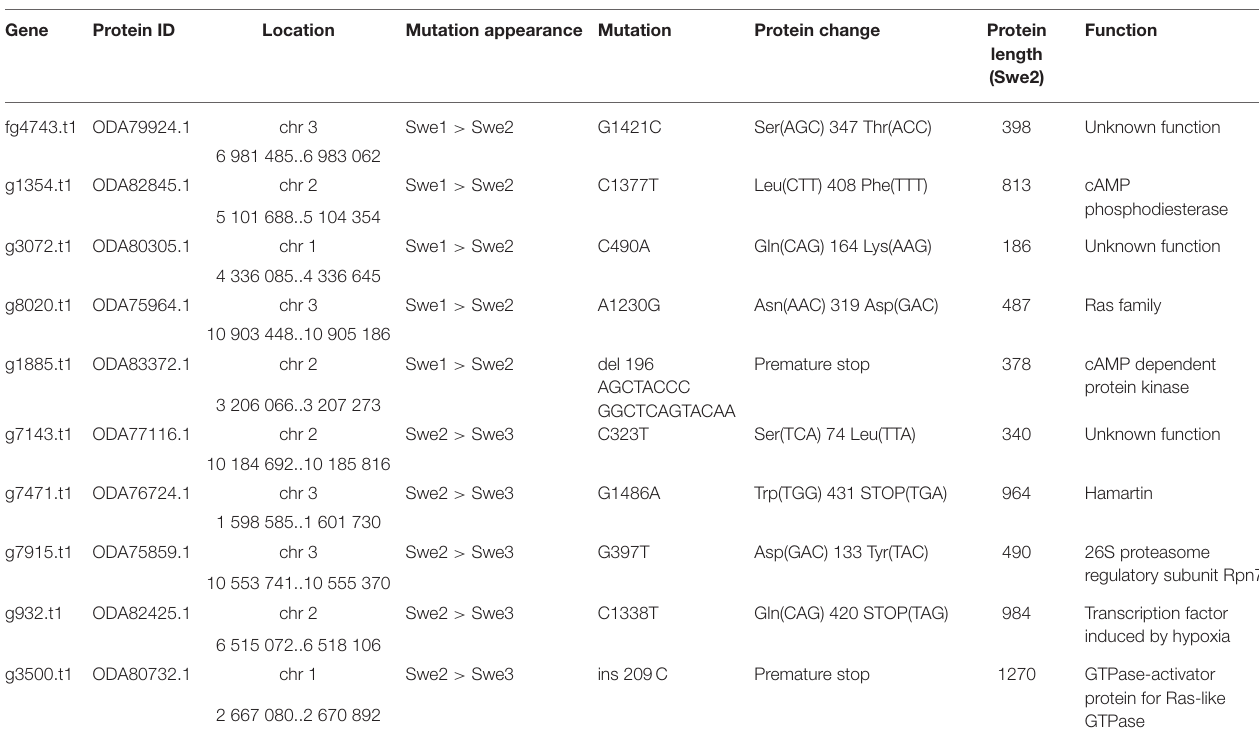
TABLE 2 | Summary of non-synonymous